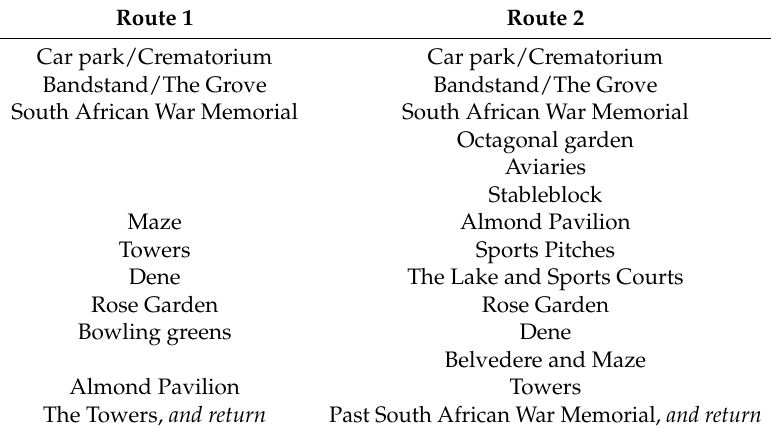
Table 1. Two semi-structured Data-Gathering Walking Routes through the